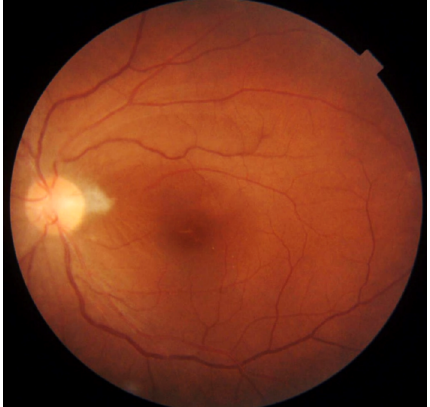
Figure 6: After the treatment, optic disc edema, focal retinal infiltrates, retinal haemorrhage, serous retinal detachment, and macular exudates Figure 5: Leakage from the optic disc of the left eye (fluorescein angiography)